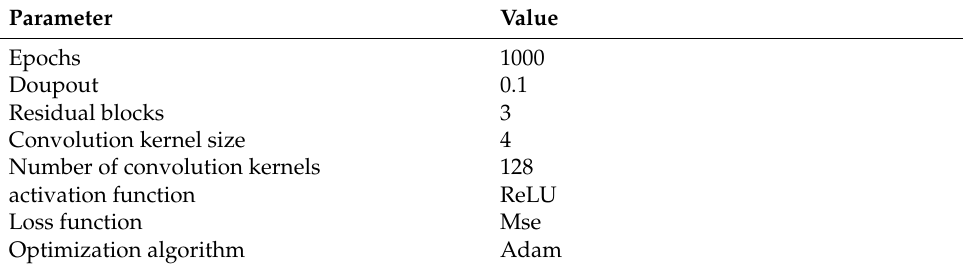
Table 6. TCN_DNNLoc model parameters.